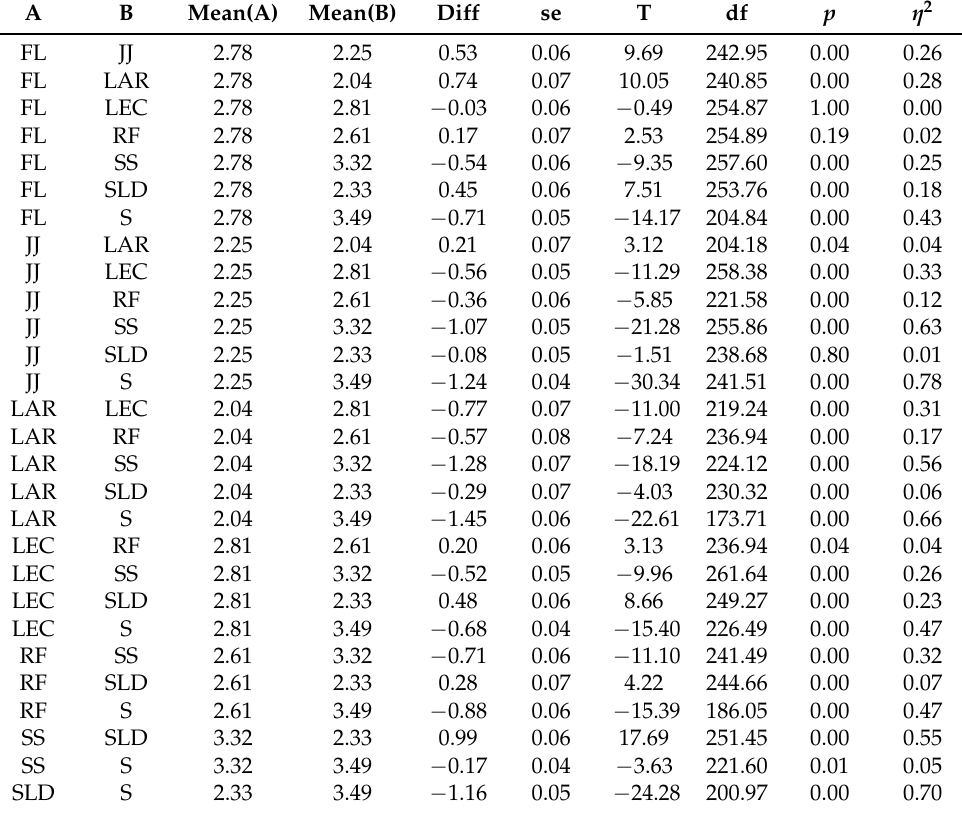
Table A1. The results of the ANOVA Post-hoc analysis of the MAE for the eight exercises Front Lunge (FL), Jumping Jacks (JJ), Lateral Arm Raise (LAR), Leg Extension Crunch (LEC), Reverse Fly (RF), Side Squat (SS), Single Leg Deadlift (SLD), and Squat (S).